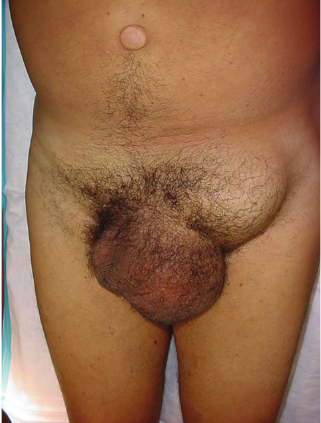
Figure 1: Clinical image of the left inguinoscrotal hernia mistakenly thought to be a bulge from contraband substances implanted subcutaneous by TSA security personnel after backscatter